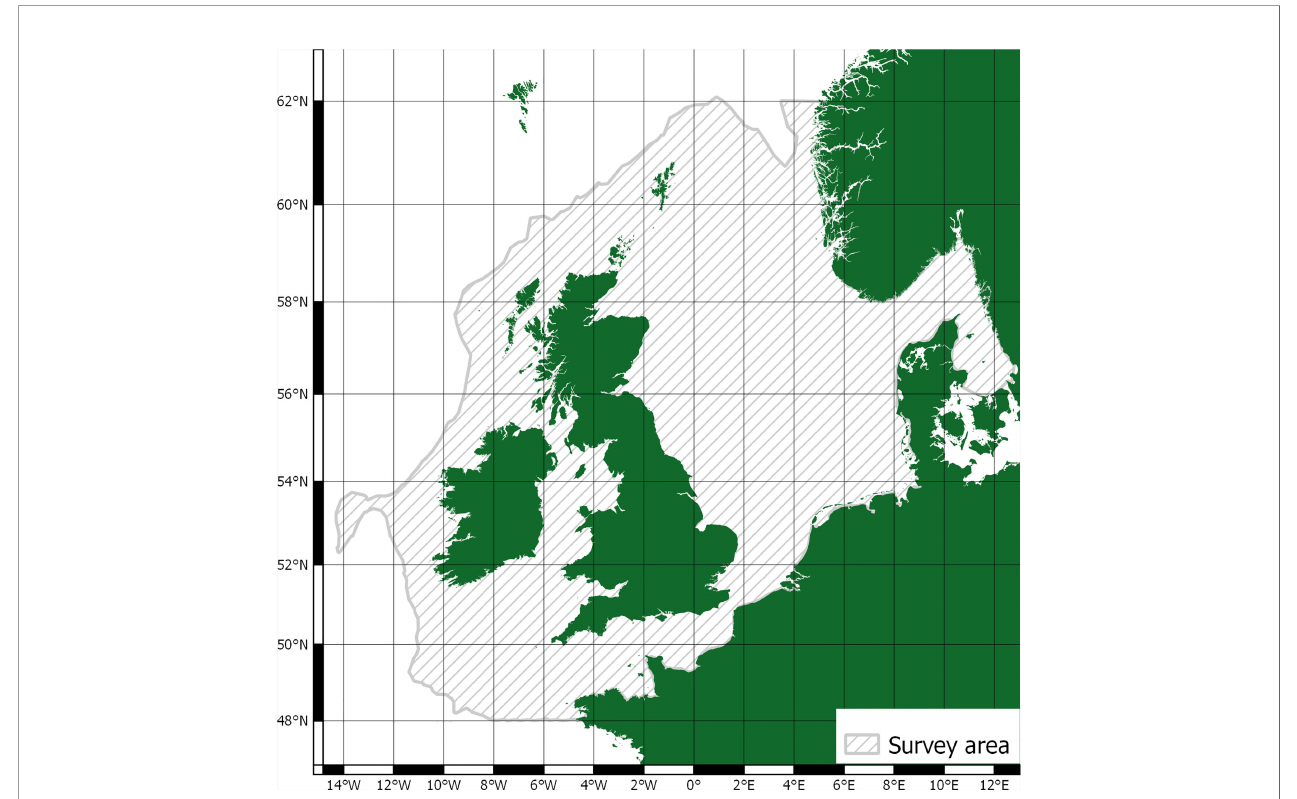
FIGURE 1 | Survey area.